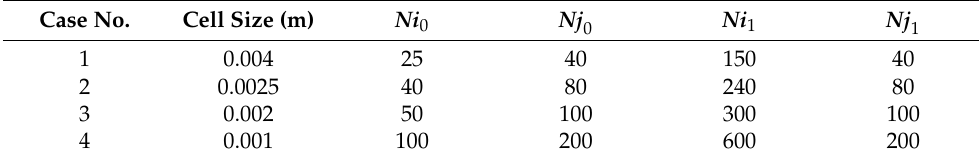
Table 5. Test of general cell